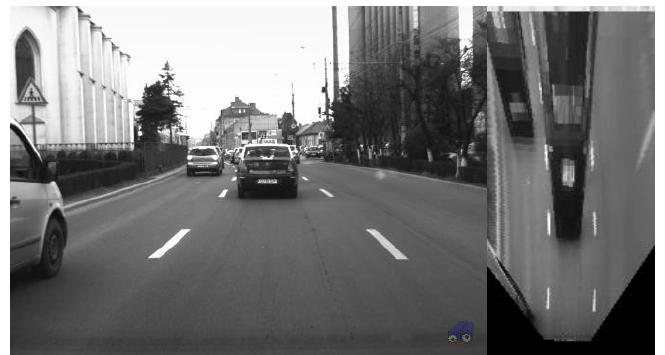
Figure 2. Removal of the perspective effect.